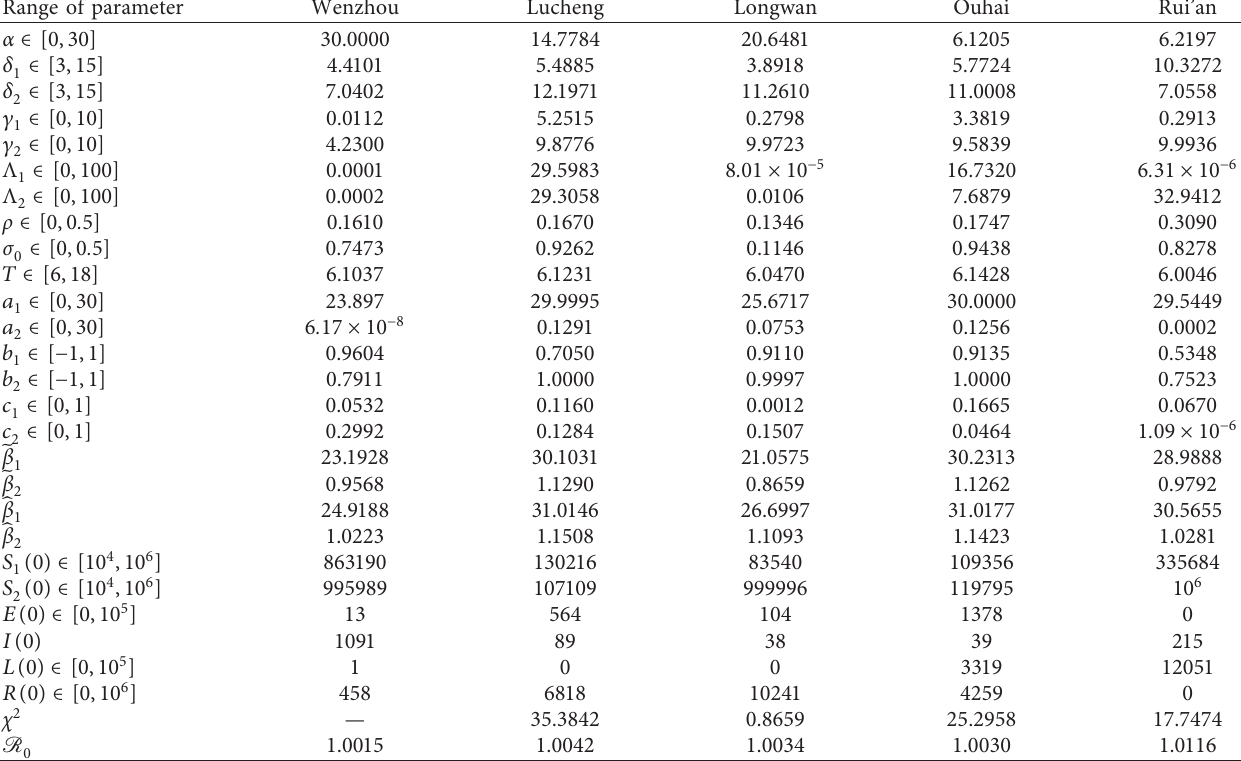
Table 1: Parameters and their values.